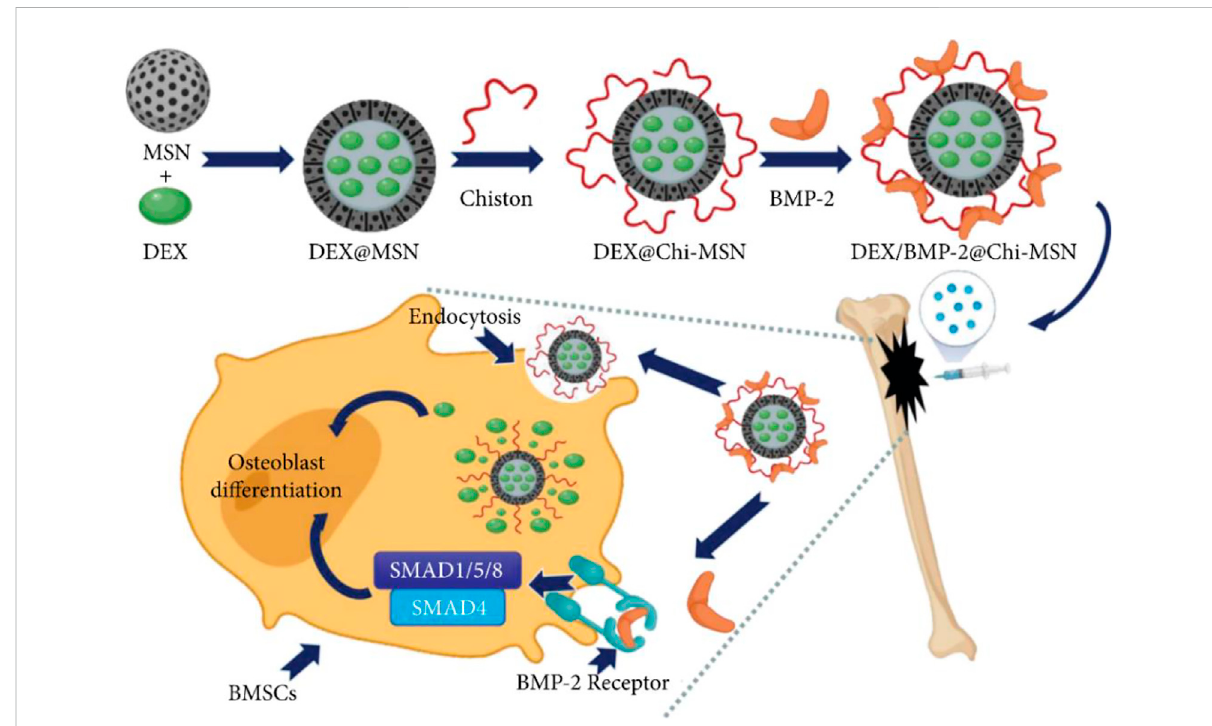
FIGURE 4 Mesoporous Silica Nanoparticle-Chitosan-Loaded BMP-2 in the Repair of Bone Defect in Chronic Osteomyelitis. Reproduced with permission from Yi et al. (2022). Copyright © 2022 The